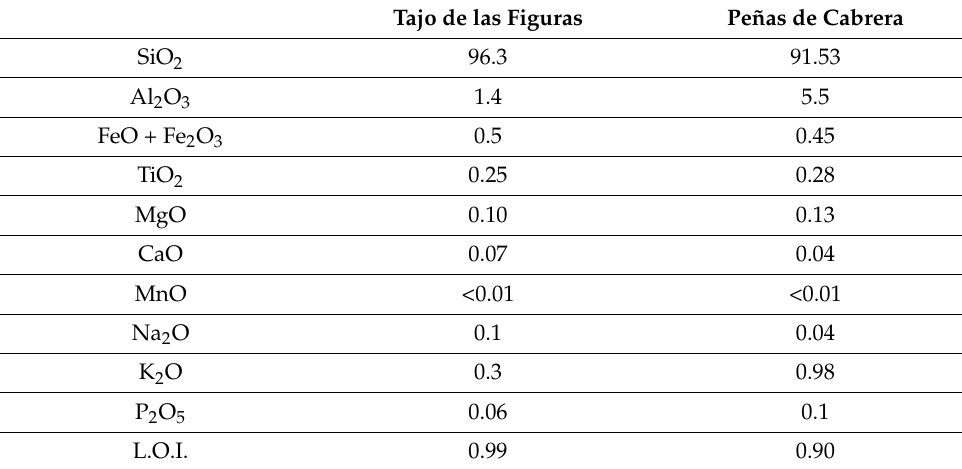
Table 1. Average chemical composition (in weight %) of fresh sandstone host